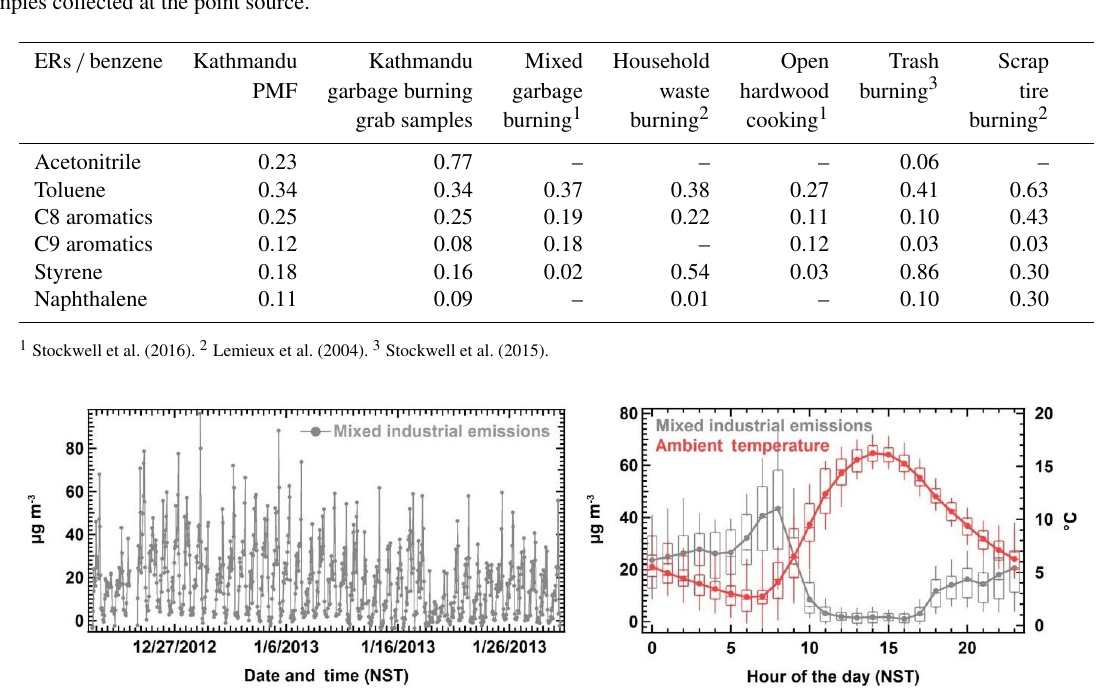
Table 5. Emission ratios of NMVOCs / benzene for acetonitrile and aromatic hydrocarbons derived from the PMF model for the factor attributed to residential biofuel use and burning household waste and comparison with previously reported studies and the garbage-burning grab samples collected at the point source.